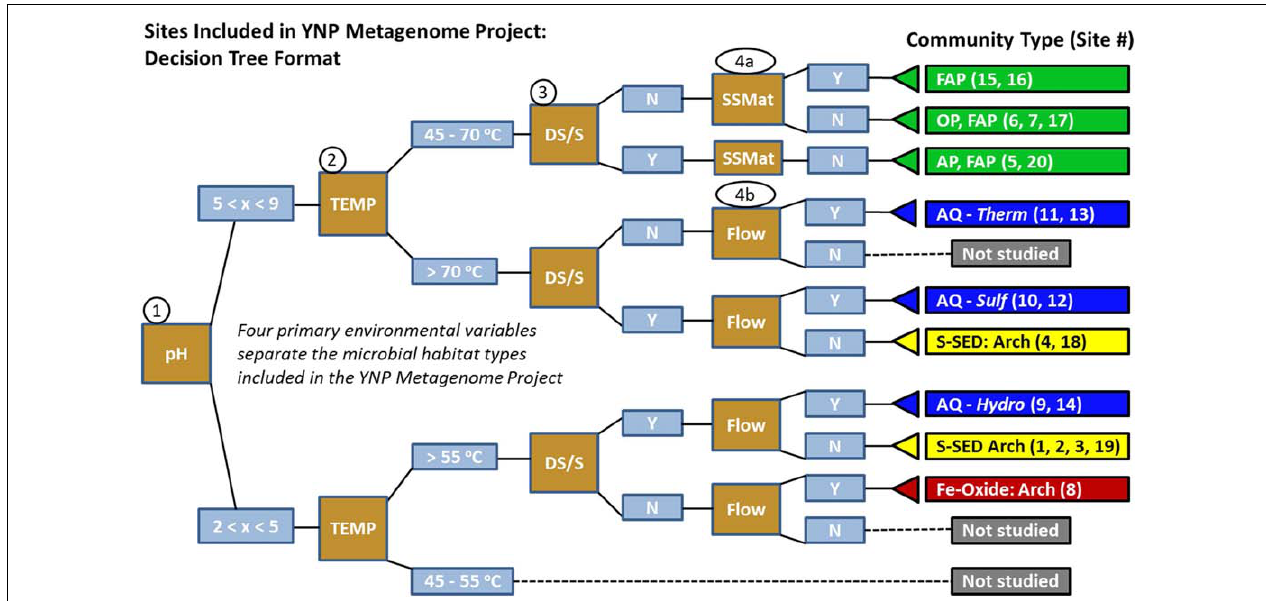
FIGURE 3 |The thermophilic microbial communities included in theYNP Metagenome Project were separated into predominant habitat types using a decision-tree with four “nodes” or primary environmental factors: pH, temperature (˚C), the presence or absence of dissolved sulfide and/or elemental S, and additional physiographic context (4a: SSMat = sub-surface sample obtained from laminated phototrophic mats; 4b: Flow = primary flow channel) . Decision nodes are represented by brown squares, node output by blue rectangles, and decision endpoints by triangles (i.e., predominant habitat types, site numbers).Targeted